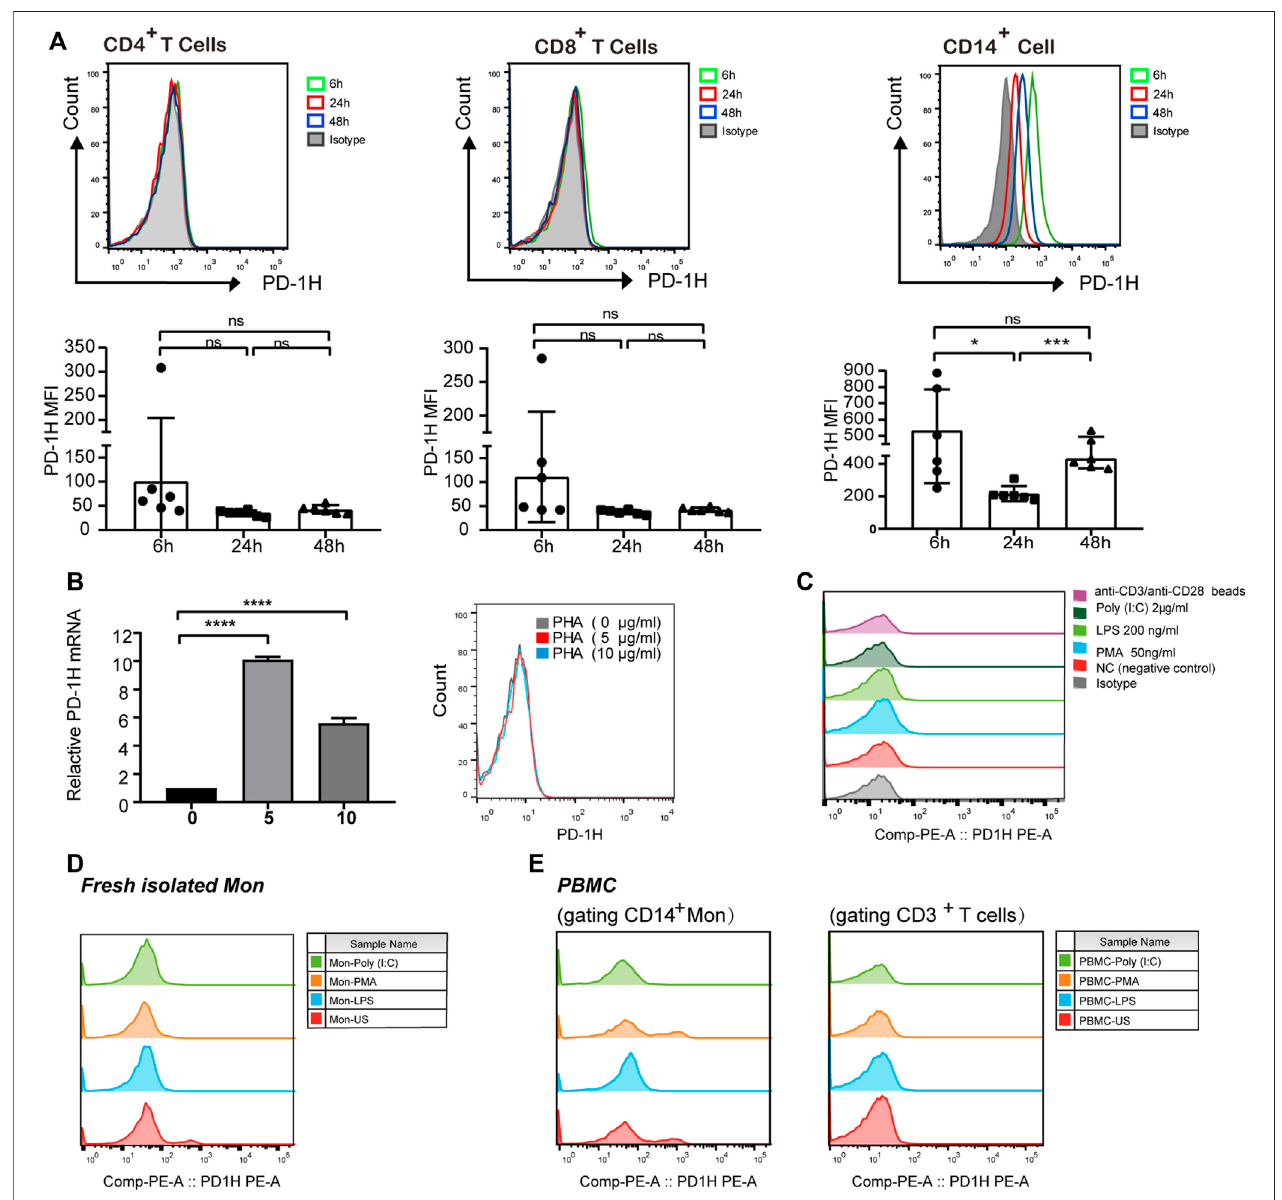
FIGURE5| PD-1HexpressioninperipheralTcellsandmonocytes. (A) PD-1HexpressiononthesurfaceofCD4 + Tcells,CD8 + Tcells,andCD14 + monocyteswas analyzed by FCM at 6, 24, and 48 h after blood collection. The expression levels of PD-1H cells are shown in a representative FCM histogram (upper graph), and the mean fl uorescence intensity (MFI) of PD-1H positive staining was pooled from two independent experiments (lower graph). (B) T cells were treated with different concentrations of PHA (0, 5, and 10 μ g/ml), and then PD-1H mRNA and PD-1H cell surface expression was analyzed by qRT-PCR (left graph) and FCM (right graph), respectively. (C) Membrane PD-1H expression was analyzed 24 h after T cells were treated with PMA (50 ng/ml), LPS (200 ng/ml), poly I:C (2 μ g/ml), or anti- CD3/anti-CD28beads. (D,E) MembranePD-1Hexpressionwasanalyzedonthecellsurfaceofpuri fi edmonocytesandPBMCsafterthecellswerestimulatedwithPMA, LPS, andpoly(I:C)for24 h.Thedataarerepresentativeofatleasttwoindependentexperiments.ns (cid:2) non-signi fi cant,* p < 0.05,*** p < 0.001,**** p < 0.0001.FCM, fl ow cytometry; qRT-PCR, real-time quantitative reverse transcription PCR; PBMC, peripheral blood mononuclear cells; Mon, monocytes; NC, negative control; PHA, polyhydroxyalkanoates; LPS, lipopolysaccharide; poly (I:C), polyinosinic:polycytidylic acid; PMA, Phorbol 12-myristate